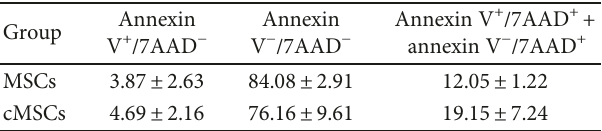
Table 1: Cyto fl uorimetric analysis of MSCs after thawing and staining with annexin V and 7AAD.